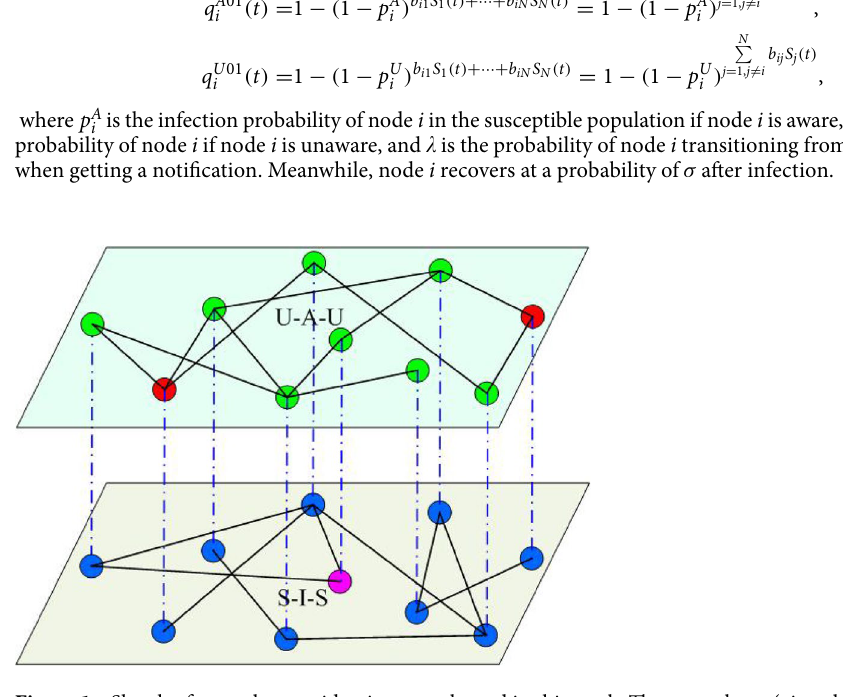
Figure 1. Sketch of a two-layer epidemic network used in this work. The upper layer (virtual contact) represents the spreading of awareness, where nodes have two possible states: unaware (U) or aware (A). The lower layer (physical contact) corresponds to the network where the epidemic spreading takes place. The nodes are the same actors as that in the upper layer, and their states can be: susceptible (S) or infected